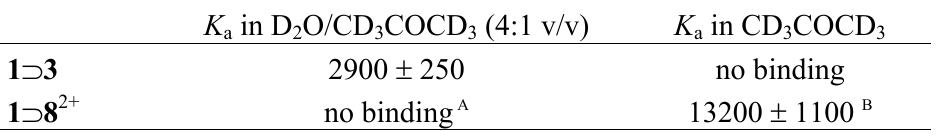
Table 1. Binding constants for the receptor 1 and the test guest species simulating the two stations of the pseudorotaxane. K values (M –1 ) were determined by 1 H NMR (300 MHz, 22 ± 1 a